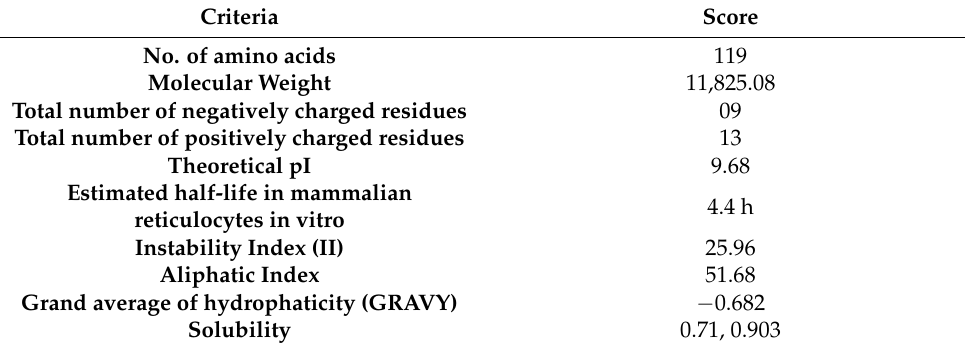
Table 3. Physiochemical properties of final vaccine